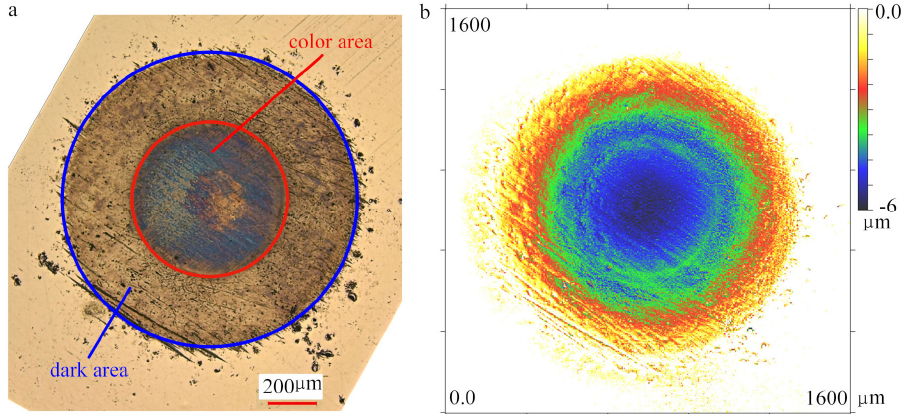
Figure 4. Photomicrograph and 3D profile of contact point on the plate. ( a ) Micrograph of optical microscope; ( b ) surface topography.